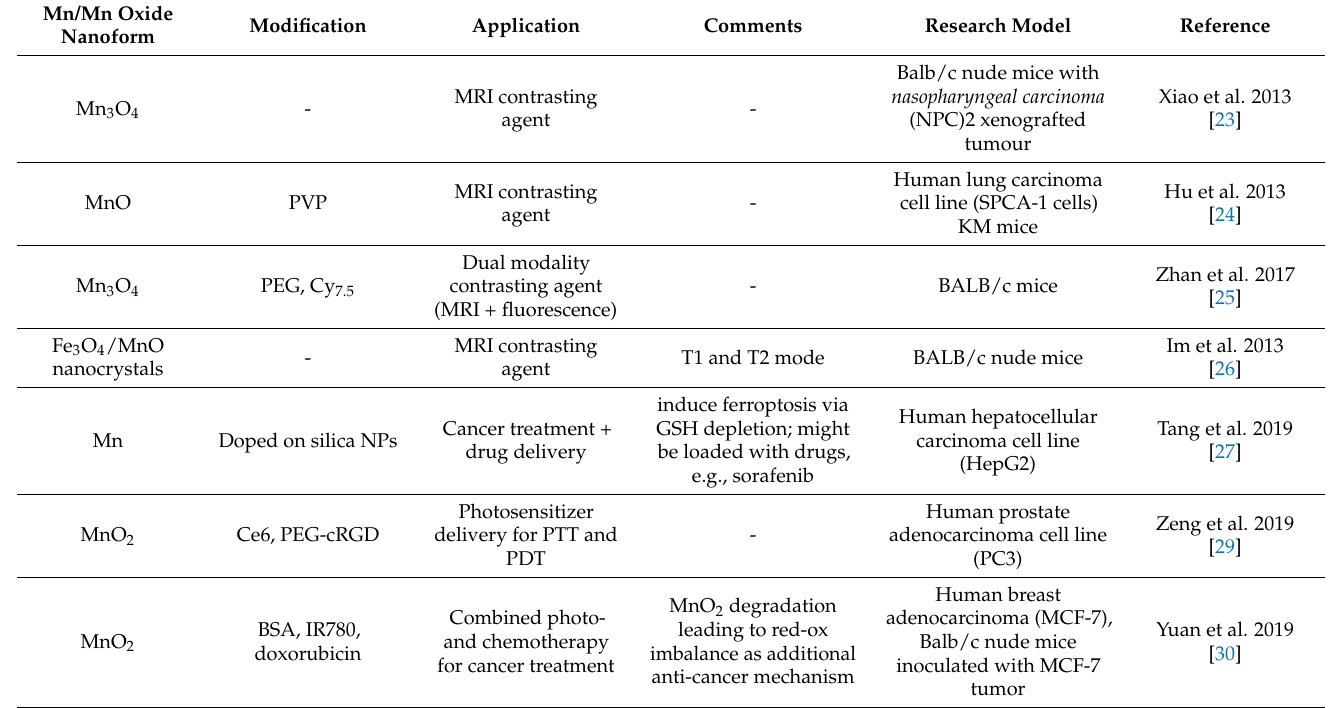
Table 1. Summary of potential medical applications of manganese oxides in